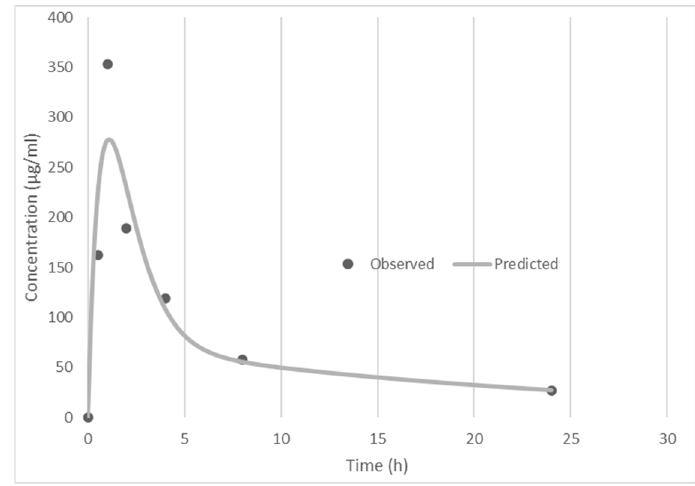
Figure 2. Day 1 Single Dose 20 mg Oral Pharmacokinetic Profile. Table 1. Pharmacokinetic analysis results.